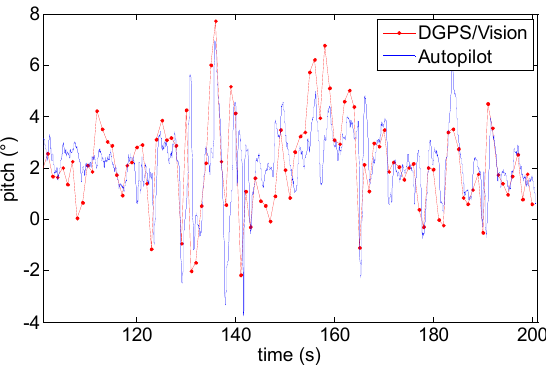
Figure 22. Roll angle as a function of time (Test 1). Sensors 2016 , 16 , 2164